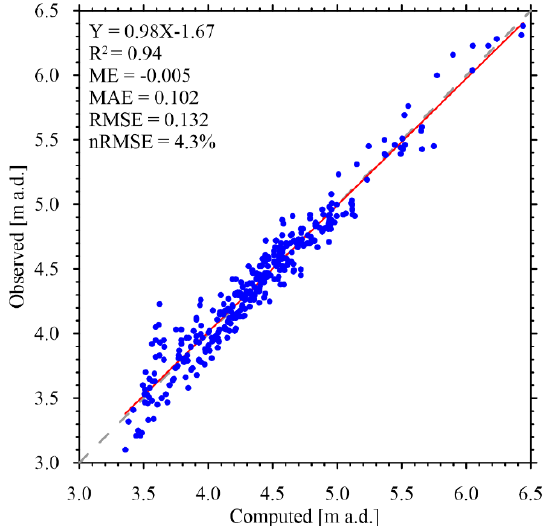
Figure 8. Observed versus computed hydraulic heads (350 data), best linear fit (solid line, with equation) and its coefficient of determination R 2 and performance metrics: Mean error ME, mean absolute error MAE, root mean square error RMSE and normalized one nRMSE. The 45-degrees line (dashed line) is reported for comparison.